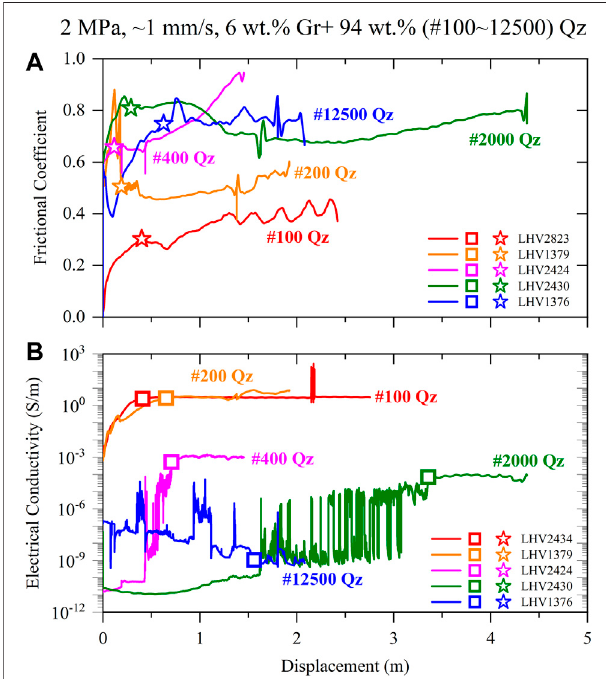
FIGURE 4 | Comparisons of the frictional coef fi cient on a linear scale (A) and electrical conductivity on a log scale (B) plotted against the slip displacements of all specimens. The colored stars and squares along each curve separately correspond to D μ ss and D σ ss .